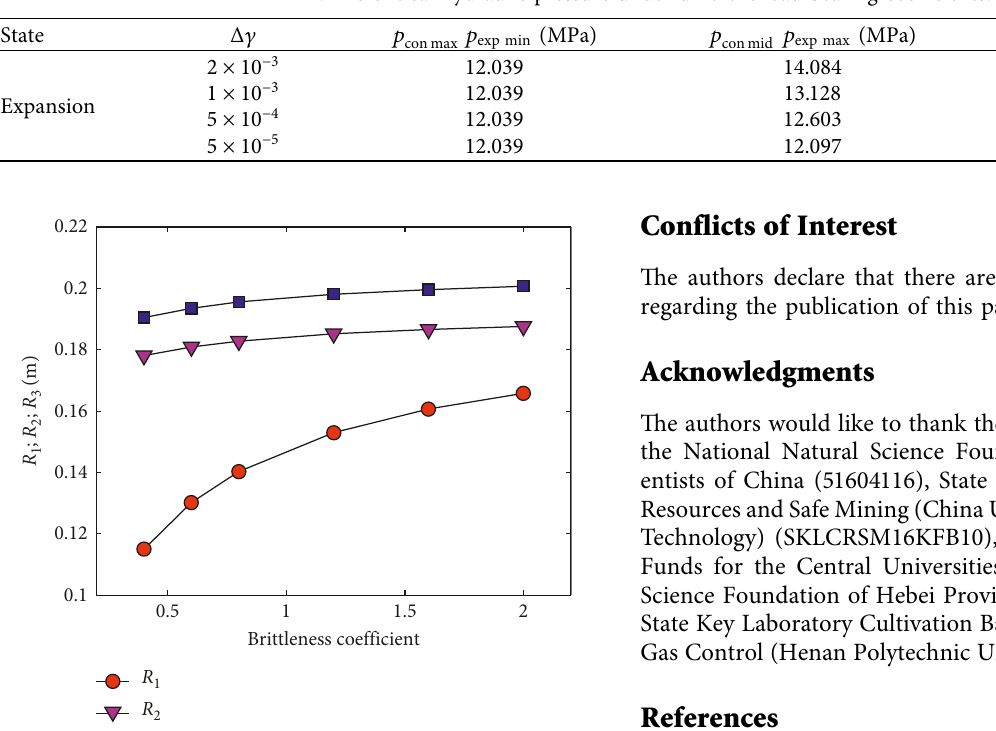
Table 4: The critical hydraulic pressure under different load-bearing coefficients.